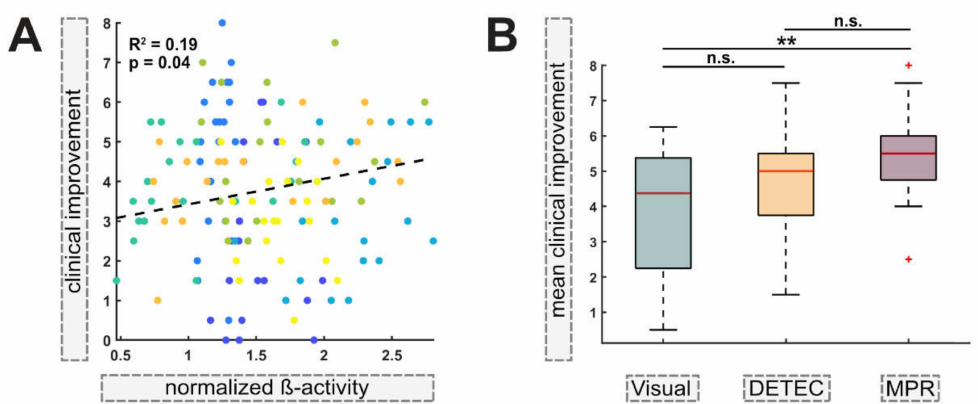
Figure 4. Beta activity as a predictor for clinical efficacy: ( A ) A linear mixed-effects model between absolute improvement in UPDRS-III items 22, 23 and 25, and ß-activity (normalized activity) for each contact (n = 140) yielded a statistically significant relationship when controlling for the individual intercept per hemisphere, explaining R 2 = 19% of variance within the model. The colors of the dots correspond to one responding (individual) patient. The dashed line represents the least-squares line of the overall model. ( B ) The boxplots show the distribution of the mean clinical improvement (improvement in UPDRS-III items 22, 23 and 25) of the best stimulation level and the best directional contact (two contacts per patient per hemisphere; n = 28) as determined using the visual approach, the algorithm and monopolar contact review (MPR). The Kruskal–Wallis test indicated a statistically significant difference among groups (chi-square = 9.71; p = 0.008; df = 2). The Tukey–Kramer post hoc test corrected for multiple comparisons if p was < 0.05. The red lines indicate the medians. The red crosses indicate outliers. ** p <